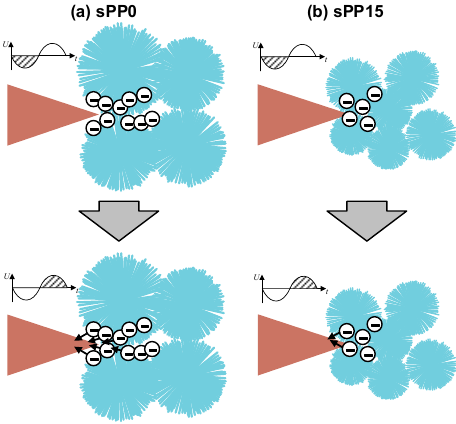
Figure 12. Schematic diagram of charge accumulation under AC voltage. ( a ) sPP0, ( b )